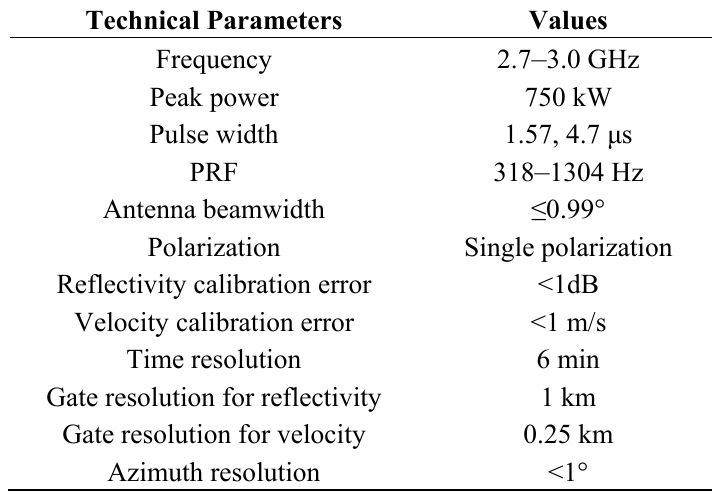
Table 1. Main technical parameters of the SA CINRAD in China.